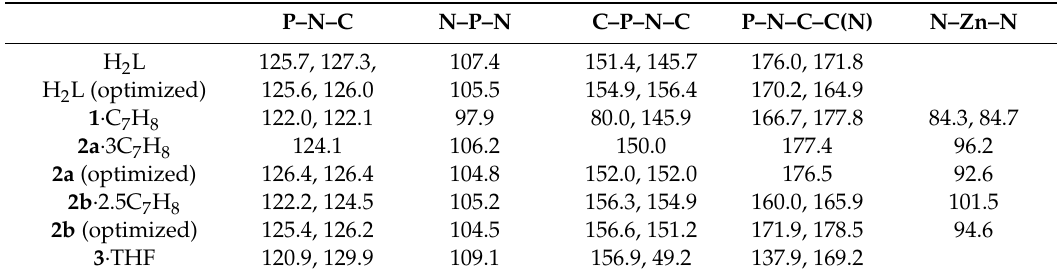
Figure 2. Molecular structure of H 2 L from XRD analysis. Table 1. Selected angles in single crystal XRD and DFT-optimized